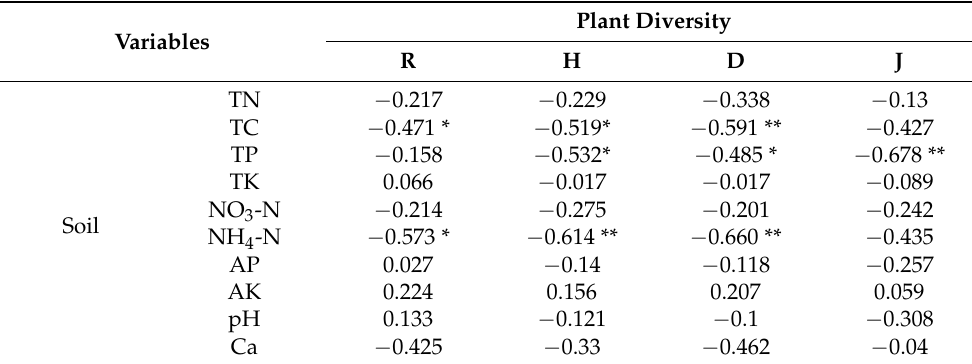
Table 1. Person’s correlation test between species diversity and soil nutrients. Plant Diversity Variables R H D J TN − 0.217 − 0.229 − 0.338 − 0.13 TC − 0.471 * − 0.519*